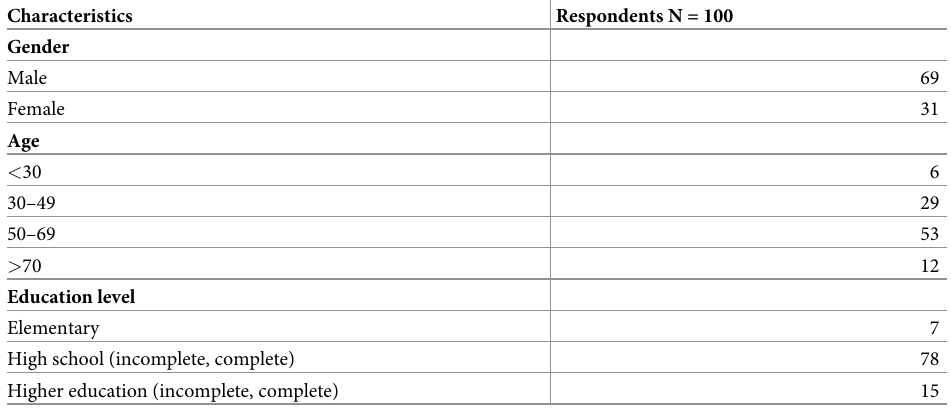
As indicated in Table 3, almost all respondents (94 out of 100) were familiar with the rabies disease. The majority were aware that dog bites (97) and cattle bites (91) are risks for exposure Table 2. Demographic characterization of